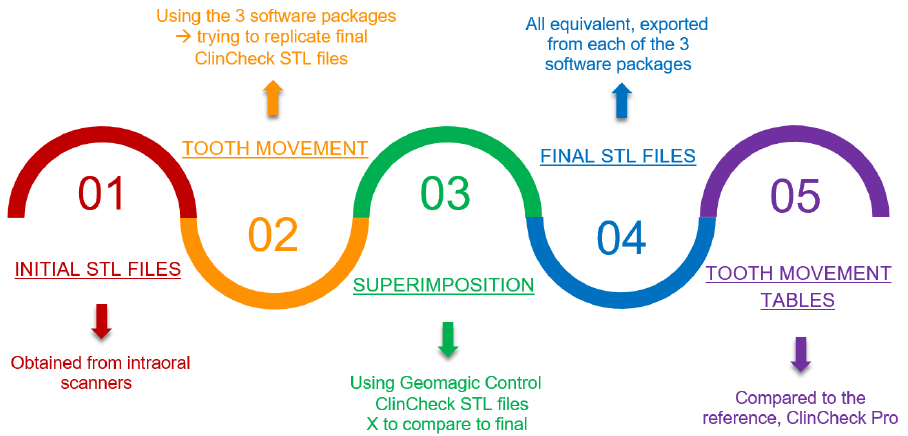
Figure 4. The workflow.